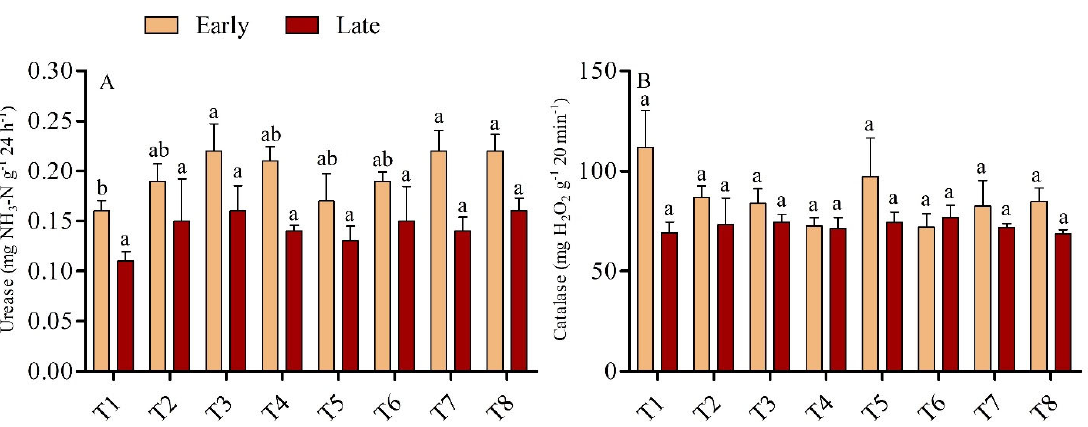
Figure 2. ( A , B ): Soil urease ( A ) and catalase ( B ) activity during the early and late seasons under low- and high-dose urea application and different levels of biochar application. Note: T1: N1B0 = 135 kg N ha −